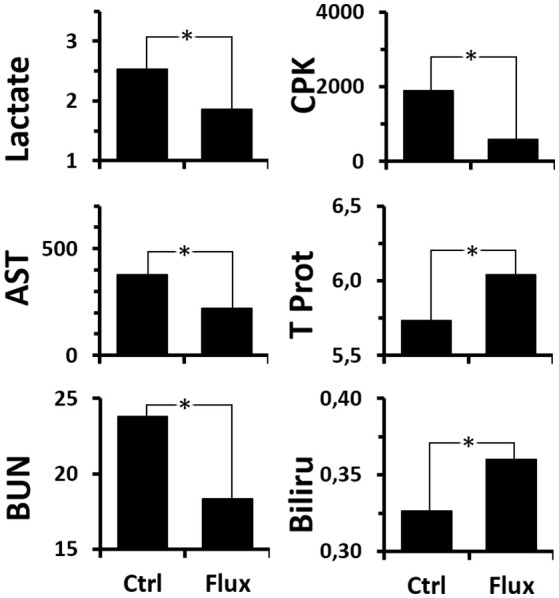
Analysis of blood biochemistry differences after the hyperbaric protocol according to rat treatments. Lactate (mmol/L), CPK/Creatinine Kinase (U/L), AST/Transaminase (U/L), BUN/UREA (mg/dL), Total Protein (g/dL), Bilirubin (mg/dL). *Significant difference (p < 0.05) (see Supplementary Table 3 for statistical details).